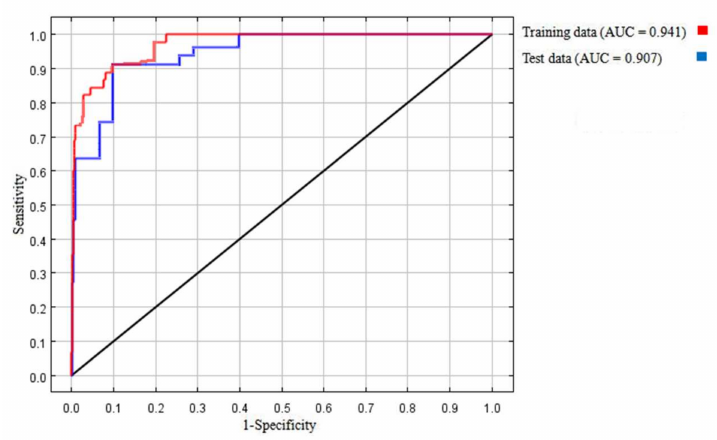
Figure 3. Receiver operating characteristic (ROC)